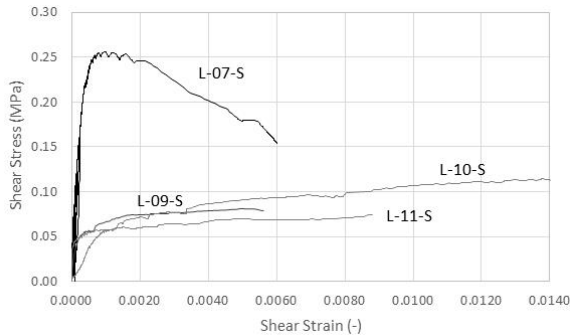
Figure 9. Shear tests carried out on stone work panels cut off from Building No. 2 (rendered panels) and Nos. 3 and 4 (non-rendered).